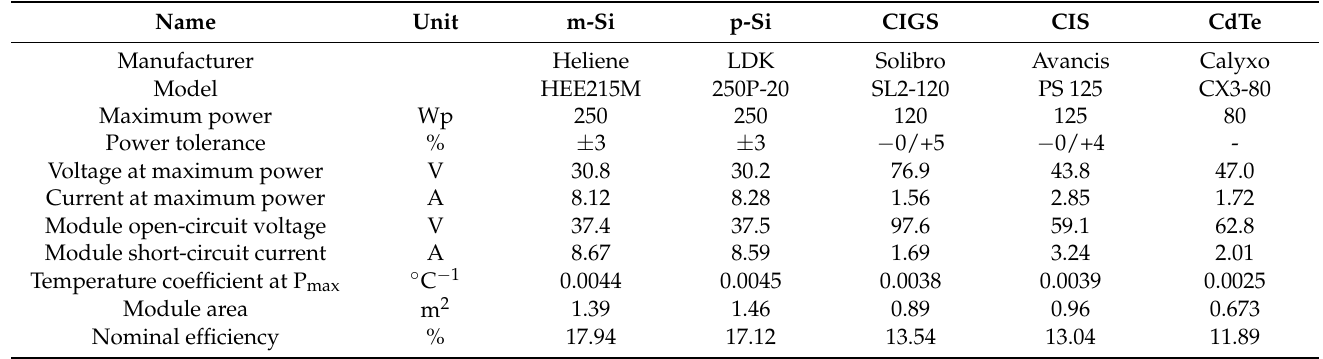
Table 2. Characteristics of the photovoltaic modules under Standard Test Conditions (STC) *.